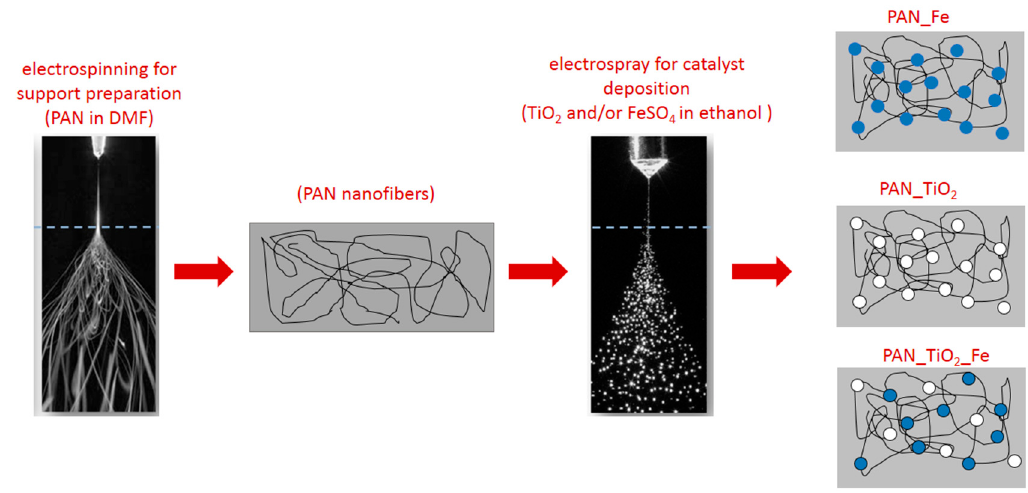
Figure 1. Schematic procedure for the preparation of nanostructured catalytic systems.